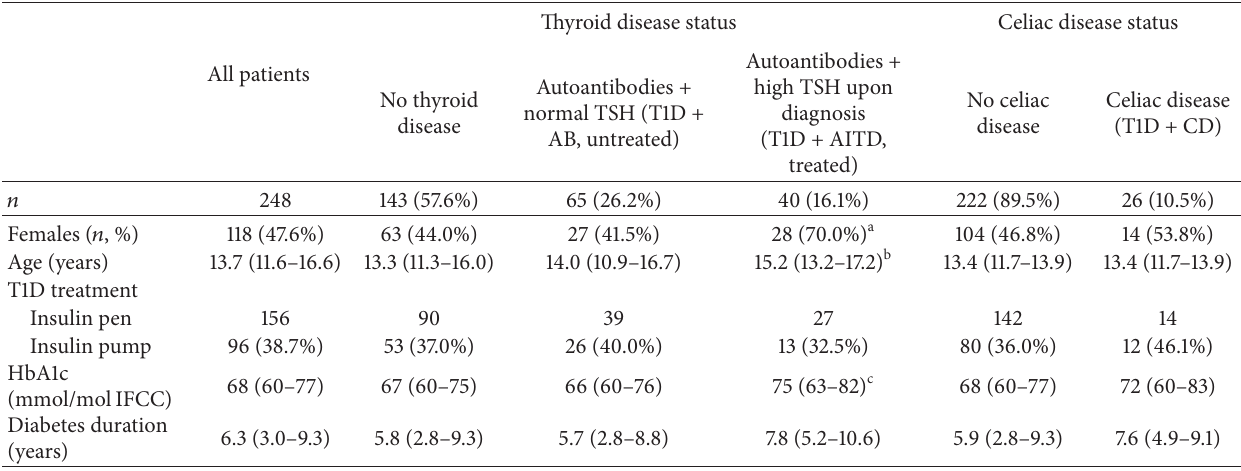
Table 1: Characteristics of